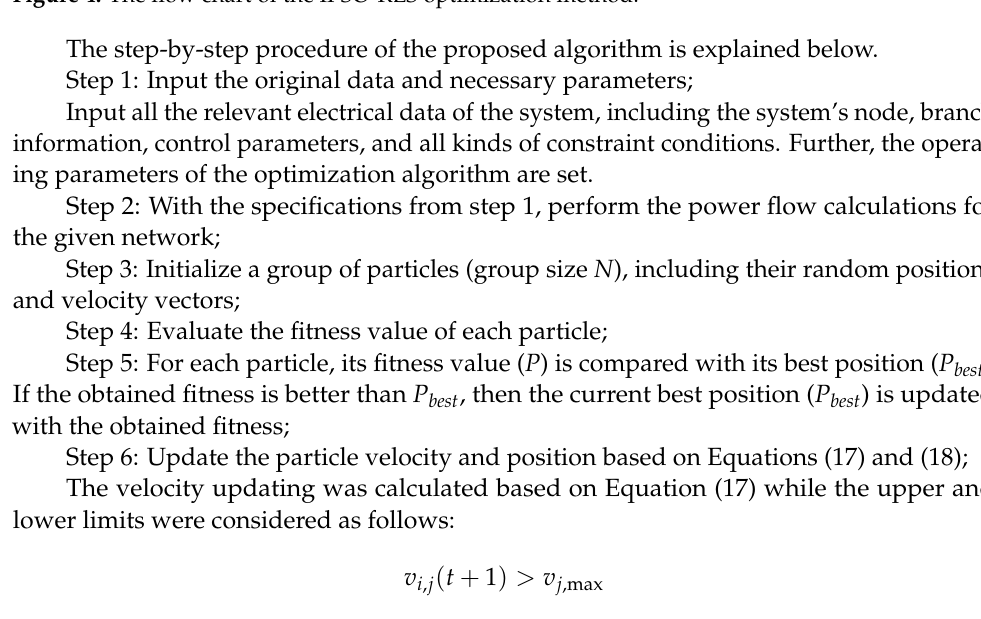
SSSR surface, and efforts should be made to improve the margin.